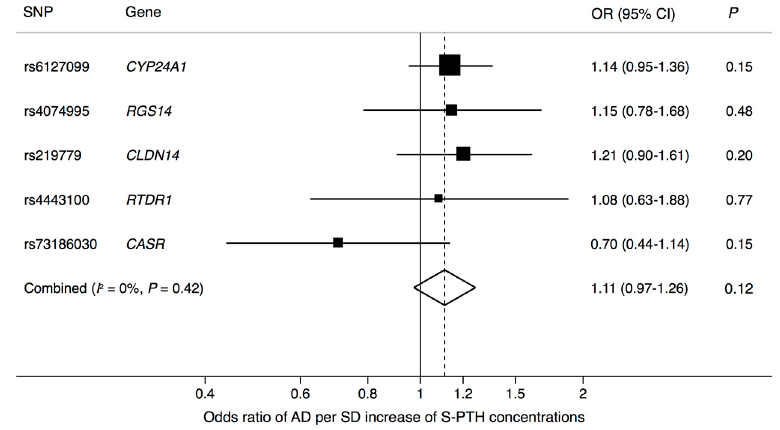
Figure 1. Association between a genetically-predicted one standard deviation increase of S-PTH concentration and AD.